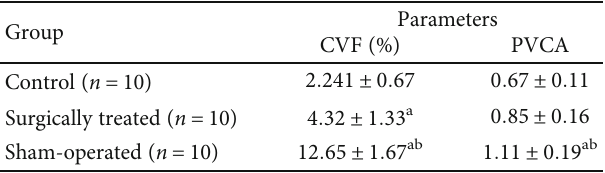
Figure 3: Pathological changes in the left ventricular myocardium of experimental dogs. (a – c) HE staining of myocardial tissue (light microscopy, 400x): (a) normal myocardial tissue in the control group, (b) the RDN group, and (c) the sham-operated group. The size and cross-sectional area of cardiomyocytes were statistically smaller in the RDN group than in the sham-operated group. Additionally, cardiomyocytes in the RDN group were arranged in a more orderly manner, similar to the control group. (d – f) Electron microscopy images of myocardial tissue (12000x): (d) the control group, (e) the RDN group: a portion of cardiomyocyte myo fi laments was dissolved and ruptured, and a fraction of the mitochondria became swollen, and (f) the sham-operated group: multifocal dissolution and fragmentation of the myo fi laments were apparent, mitochondrial and cellular swelling was evident, and the numbers of the mitochondria and cells were markedly reduced. (g – i) Masson ’ s trichrome staining of myocardial tissue (light microscopy, 400x): (g) the control group, (h) the RDN group: a small number of collagen fi bers were deposited in the myocardial stroma, and (i) the sham-operated group: large numbers of collagen fi bers were produced in the myocardial stroma (red indicates cardiomyocytes, blue indicates collagen fi bers, and red arrow points to collagen fi ber). (j – l) Masson ’ s trichrome staining of myocardial tissue (light microscopy, 400x): (j) the control group, (k) the RDN group: a small number of collagen fi bers were deposited in the perivascular area, and (l) the sham-operated group: large numbers of collagen fi bers were produced in the perivascular area (red indicates cardiomyocytes, blue indicates collagen fi bers, and red arrow points to collagen fi Table 4: Changes in collagen volume fraction (CVF) and perivascular circumferential collagen area (PVCA) in the left ventricular myocardium in experimental dogs ( (cid:1) x ± S ).